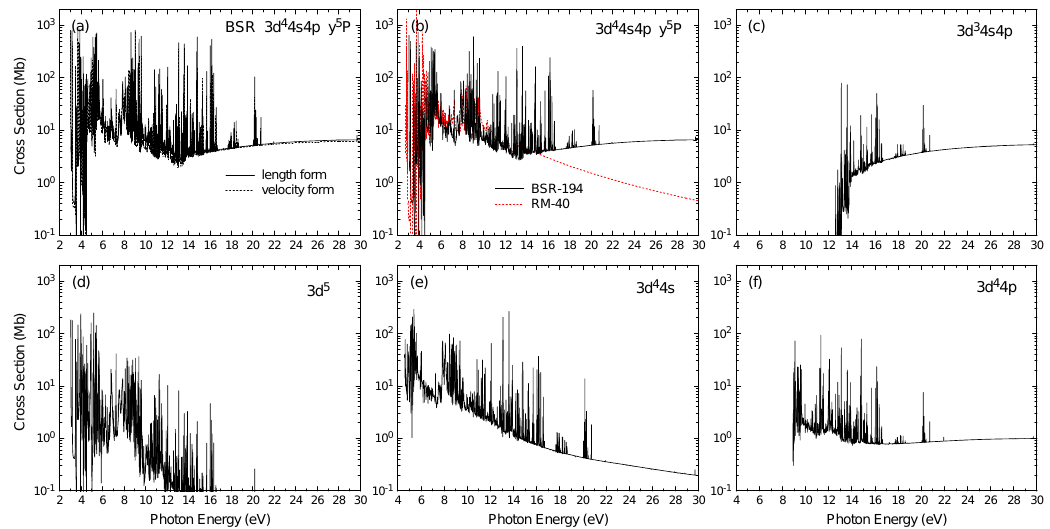
Figure 5. Total and partial photoionization cross sections from the excited 3 d 5 4 p y 5 P state of Cr I as a function of photon energy. Panel ( a ) shows total cross sections from the present BSR-194 model in the length and velocity forms. Panel ( b ) compares the BSR-194 model with the RM-40 calculations of Nahar [14]. Panels ( c – f ) show summed partial cross sections for leaving the residual Cr II ion in final states of the 3 d 5 , 3 d 4 4 s , 3 d 4 4 p , and 3 d 3 4 s 4 p configurations,